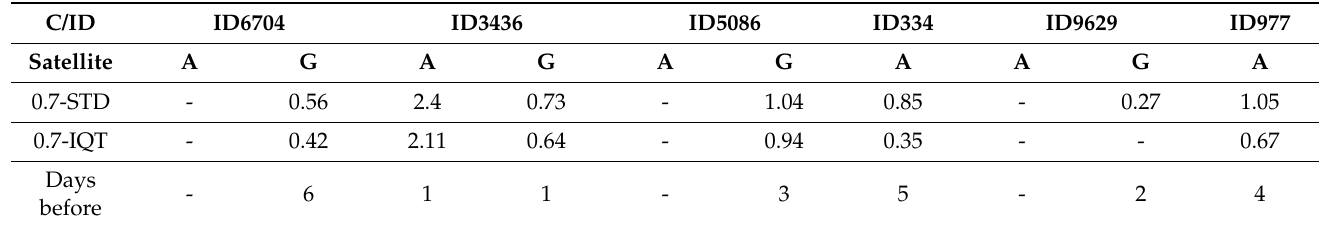
Table 7. Measured LST Anomalies ( ◦ C) from GOES and AQUA M w > 6 Studied Earthquakes In